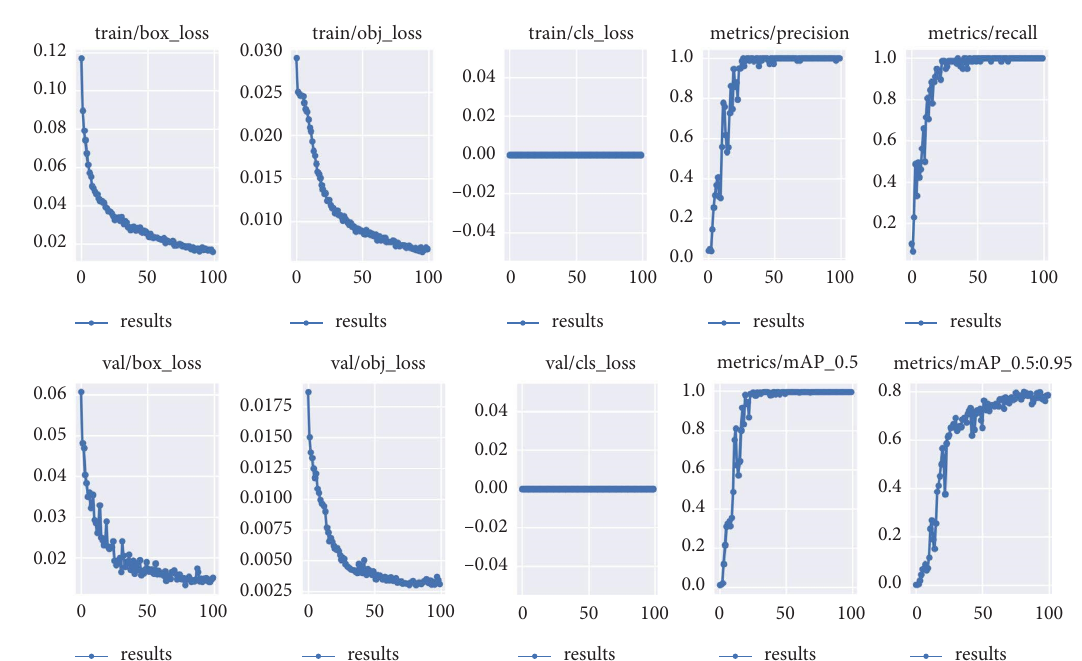
Figure 10: Box loss, objectness loss, classifcation loss, precision, recall, and mean average precision (mAP) plots for the training and validation set.